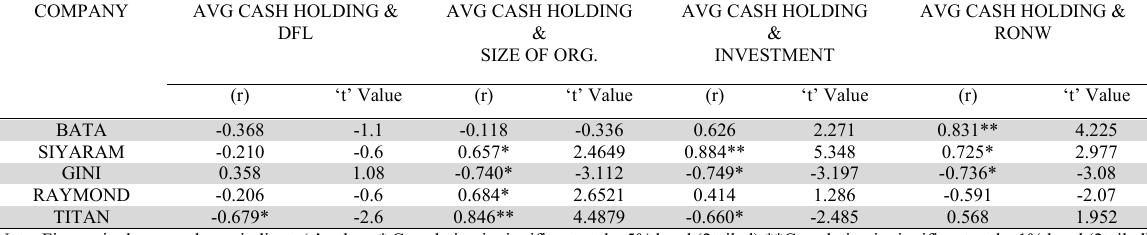
Karl Pearson’s Simple Correlation Analysis between AVG Cash Holding and DFL, Size of Org., Investment and RONW of the Selected Companies of Retail Sector COMPANY